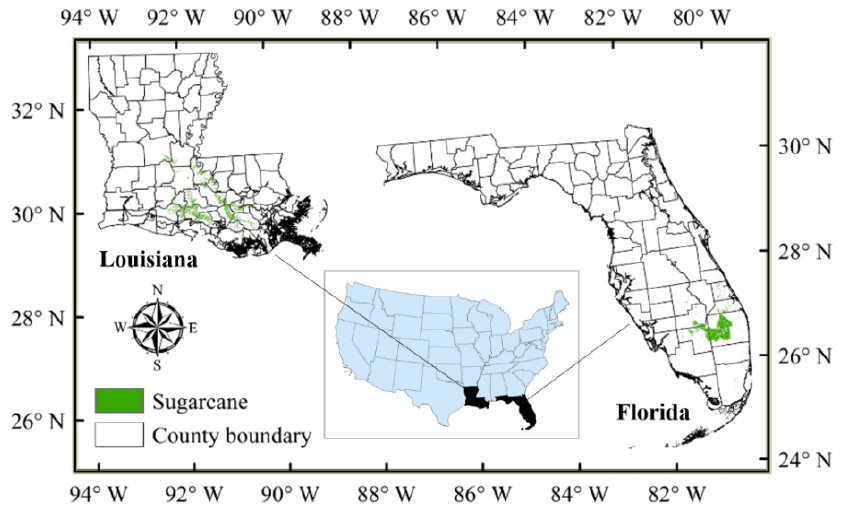
Figure 1. Study areas and the locations of sugarcane planting areas.